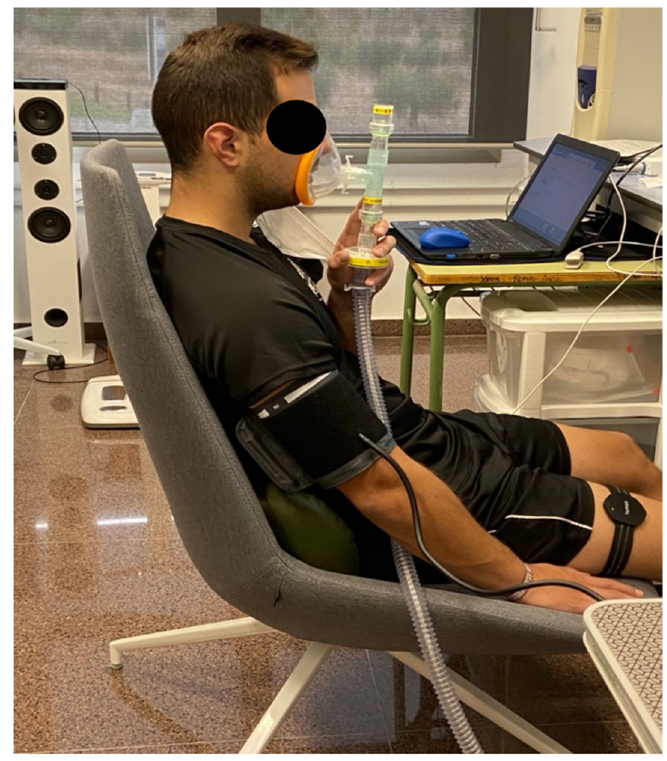
Figure 2. A subject performing the normobaric hypoxia tolerance test. During both tests, arterial oxygen saturation and muscle oxygen saturation (SmO 2 ) values were